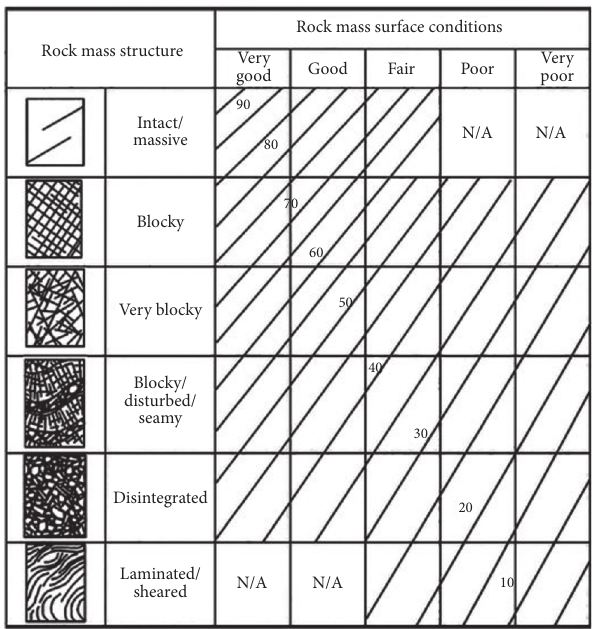
Figure 6: Estimation of geological strength criterion